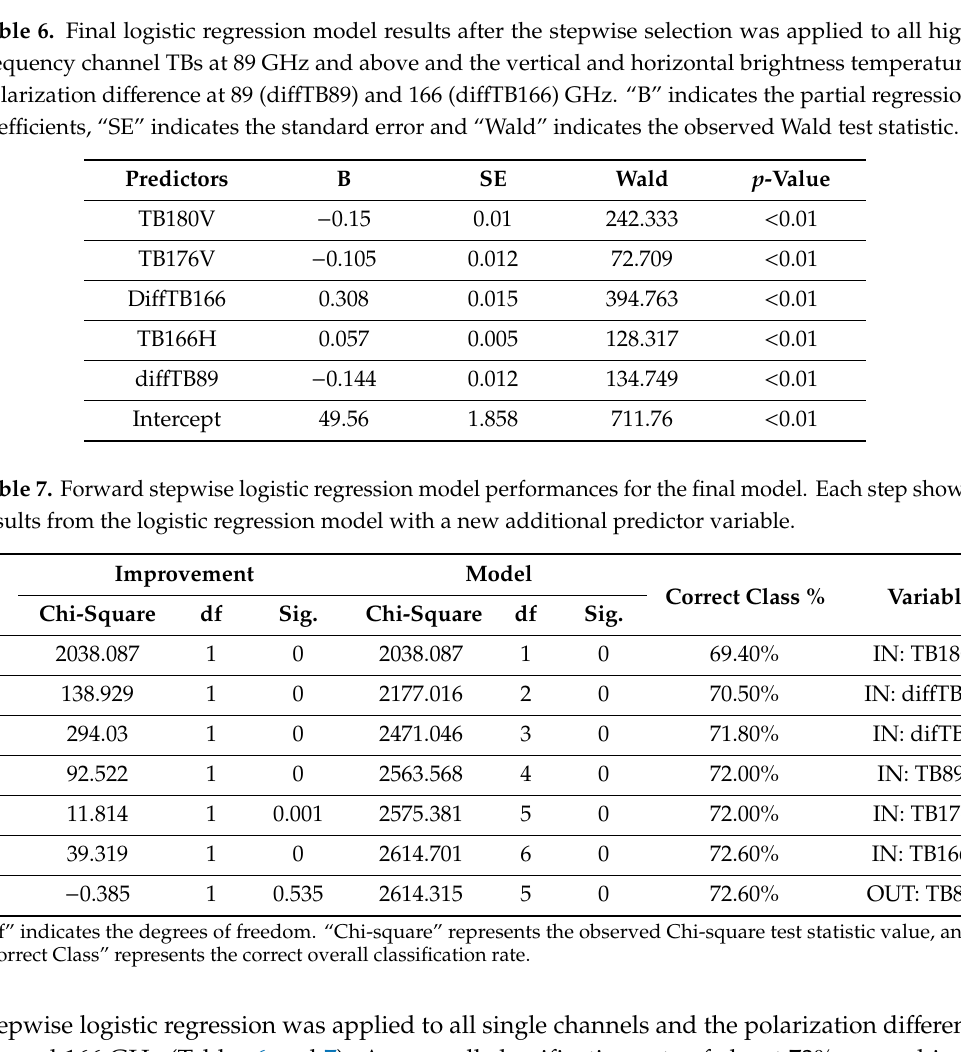
Stepwise logistic regression was applied to all single channels and the polarization di ff erences at 89 GHz and 166 GHz (Tables 6 and 7). An overall classification rate of about 73% was achieved by including the 183.31 ± 3 GHz and 183.31 ± 7 GHz vertical polarization channels. Note in Table 7 the improved performance by adding Di ff TB166 (step 2) and Di ff TB89 (step 3) to TB80V, and the removal of TB89 at vertical and horizontal polarization and TB166 at vertical polarization from the final model (due to a p -value higher than